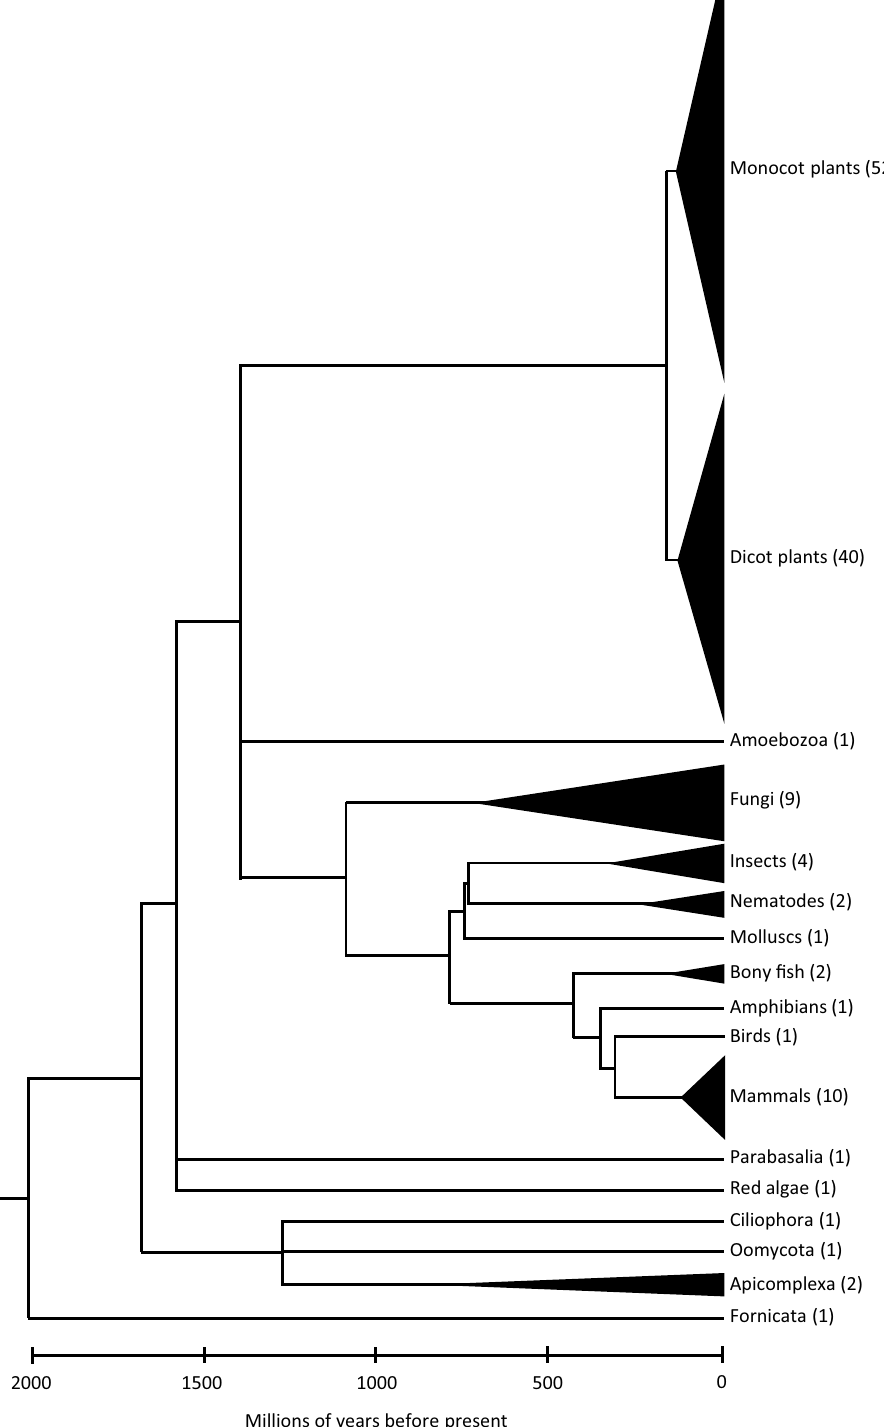
Figure 1. A simplified phylogenetic tree shows the distribution of analyzed taxa across Eukaryotes. Numbers in brackets correspond to the number of analyzed species from the respective